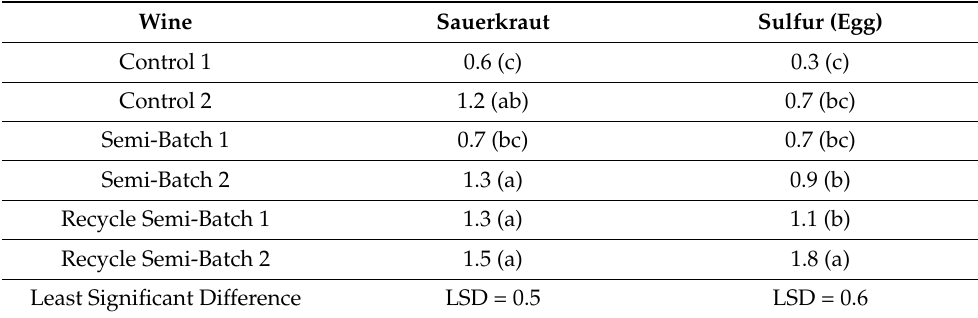
Table 4. Significant aroma differences and their Least Significant Differences (LSD). Differences in aroma score greater than LSD indicate a meaningful difference between the samples. Note that letters represent significant groupings based on Fisher’s Least Significant Difference (LSD) test p < 0.05. Wine